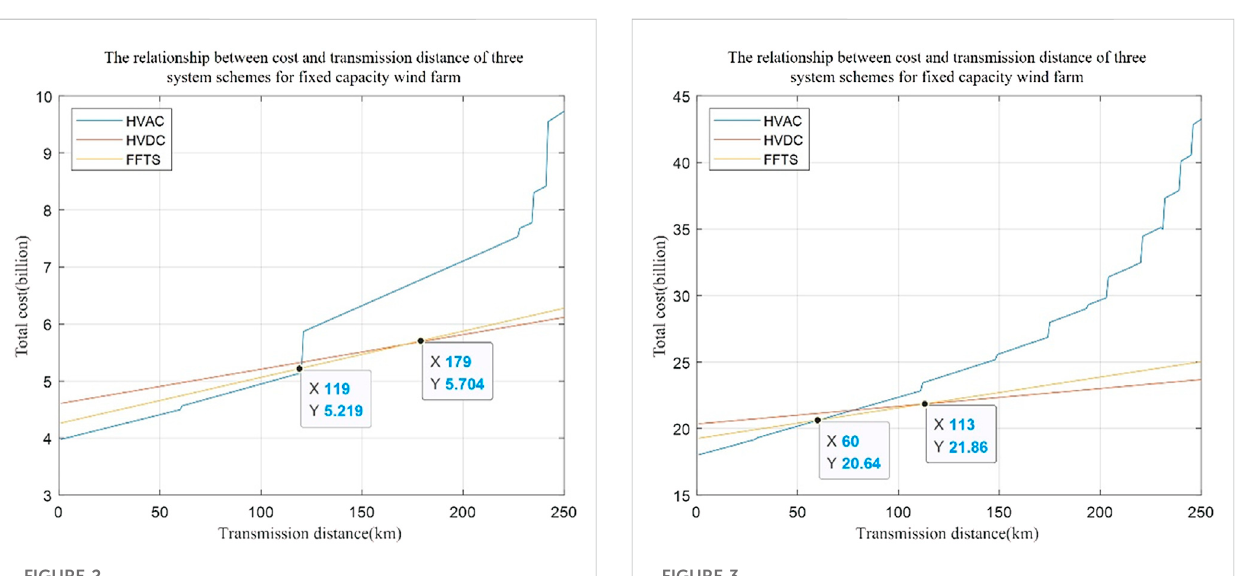
FIGURE 2 Comparison of cost distance curves of three system schemes under AC grid connection of 300 MW wind farm.